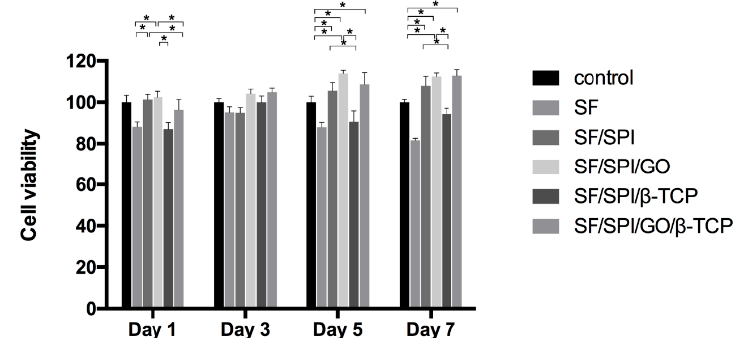
Figure 10. Proliferation of BMSCs on the SF/SPI-based scaffolds on day 1, 3, 5, and 7. Statistical significance relative to each group: * p < 0.05.